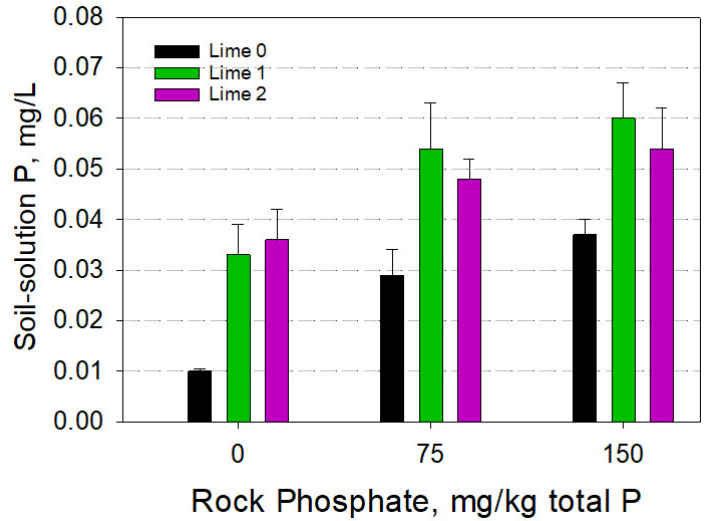
Figure 6. Soil-solution P as affected by rock P and lime amendments to an acid Oxisol. Error bars on top of larger bars are standard deviation of the measured samples.